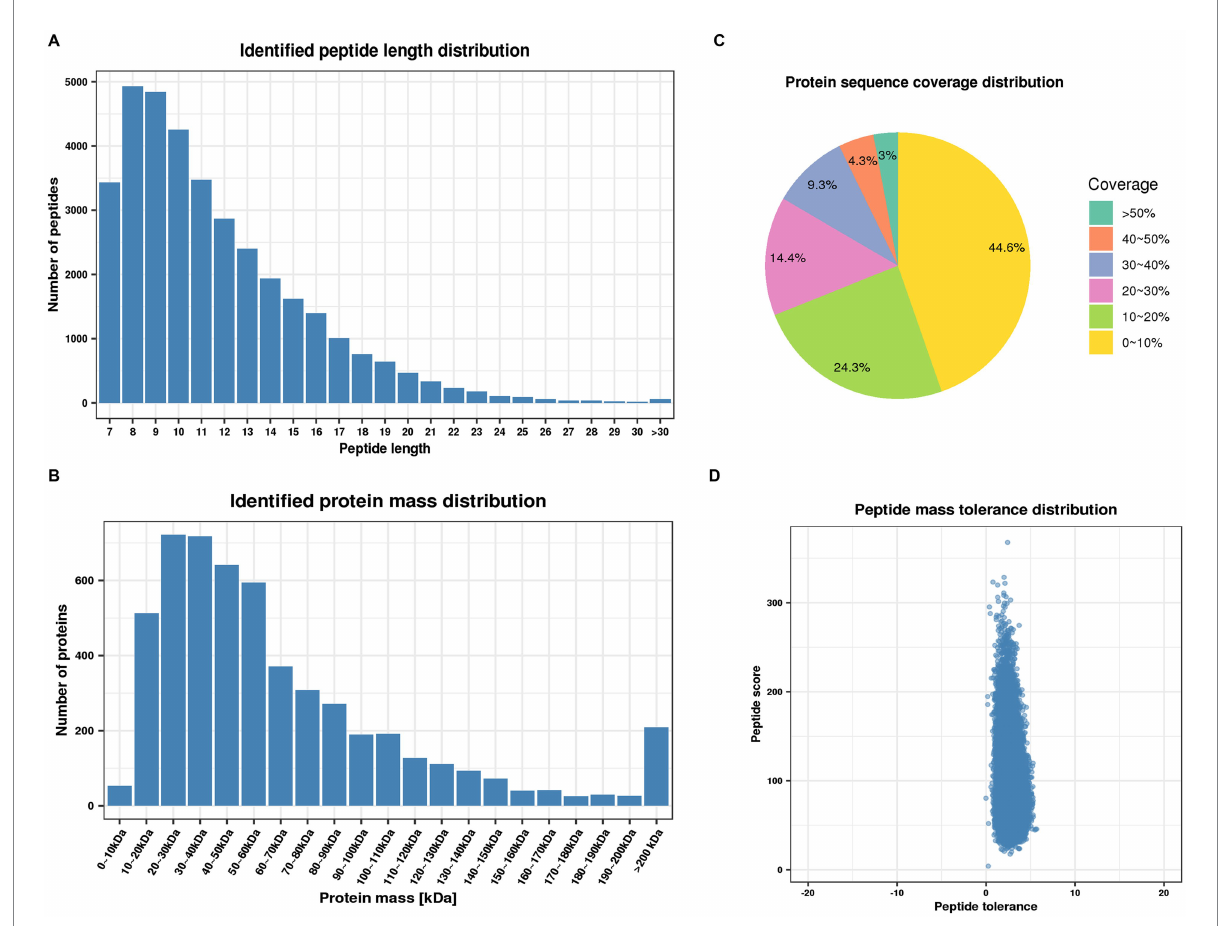
WT-d3 group at 3 dpi (Figure 3D). By contrast, the up-regulated proteins were distributed in extracellular, nucleus and cytosol (Supplementary Figure S1A) and down-regulated proteins were distributed in cytosol, nucleus and mitochondria (Supplementary Figure S1B) in both WT-d3 vs. WT-d0 and KO-d3 vs. KO-d0 groups after PR8 virus